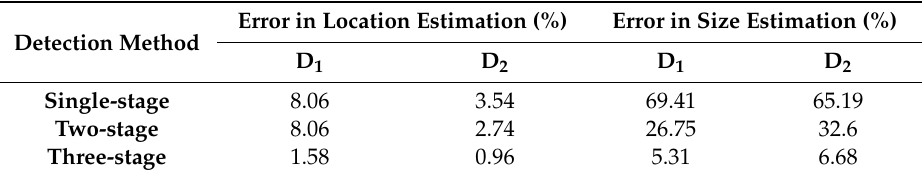
Table 3. Comparison of results for multiple damages.